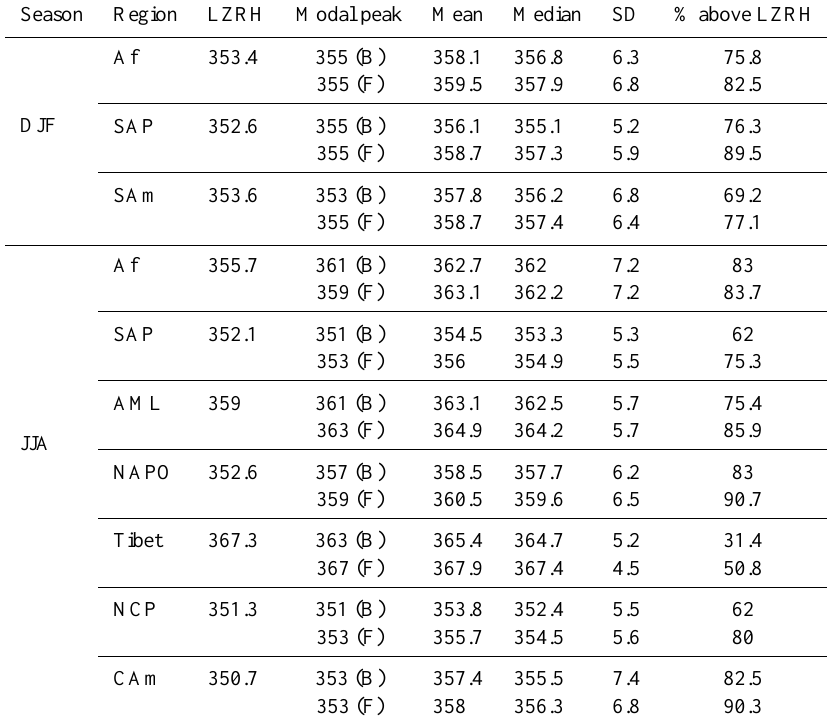
Table 1. Characteristic numbers of the vertical distribution of sources for the contributing regions during boreal winter (DJF) and boreal summer (JJA). All the quantities but the last column are potential temperatures in units of K. The modal peak is based on the discretized mean histogram shown in Fig. 3. The mean, median and standard deviation are calculated from a cubic spline interpolation over the 340– 380K interval. For each region and each season the upper line refers to backward calculations and the lower line to forward calculations as indicated in the modal peak column. Regions with low contribution have been masked.